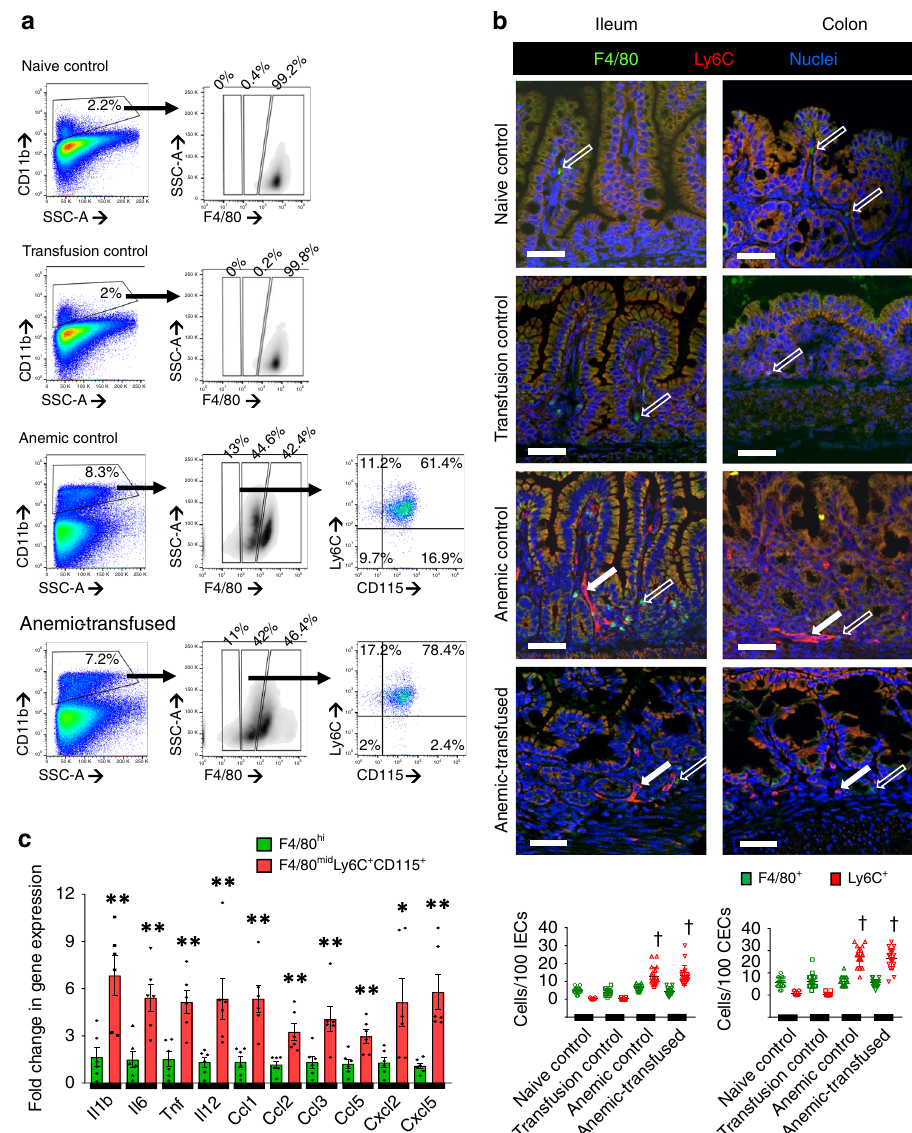
Fig. 4 Macrophage in fi ltration in red blood cell (RBC) transfusion-associated necrotizing enterocolitis (NEC). a Representative scatter plots from control and anemic-transfused mice. The CD11b ( + ) myeloid cell fraction was enriched in anemic and anemic-transfused mice, and clustered into discrete F4/80 (hi) and F4/80 (mid) populations. The F4/80 (mid) macrophage population in anemic and anemic-transfused mice was CD115 ( + ) and Ly6C ( + ). b Fluorescence photomicrographs (ileum, colon; magni fi cation ×800) showed scattered F4/80 ( + ) macrophages (green, open arrows) in naive and transfusion control. Numerous Ly6C ( + ) cells (red, solid arrows) were also seen in anemic and anemic-transfused intestine. Scale bar = 50 µ m. Scatter plots below summarize the number of Ly6C ( + ) and F4/80 ( + ) cells in each group. Kruskal – Wallis H test with Dunn ’ s post test, † P < 0.001 vs. naive control. Data represent 10 mice per group. c Scatter bar diagrams summarize LPS-stimulated in fl ammatory cytokine expression in the F4/80 (hi) and F4/80 (mid) cell populations in vitro, measured by reverse transcriptase-quantitative polymerase chain reaction (RT-qPCR). N = 8 mice per group; Mann – Whitney U test, * P < 0.05, ** P <